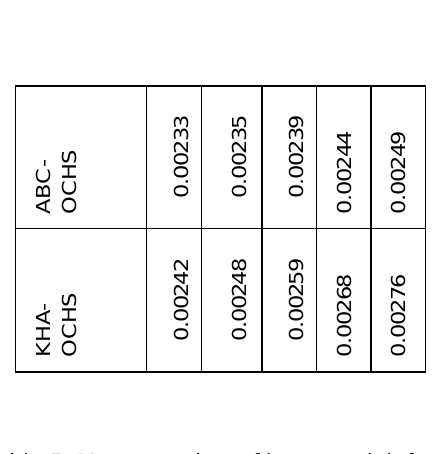
Table 5 . Mean number of hops to sink for the proposed NIUS-HEHOA-OCHS Size of the